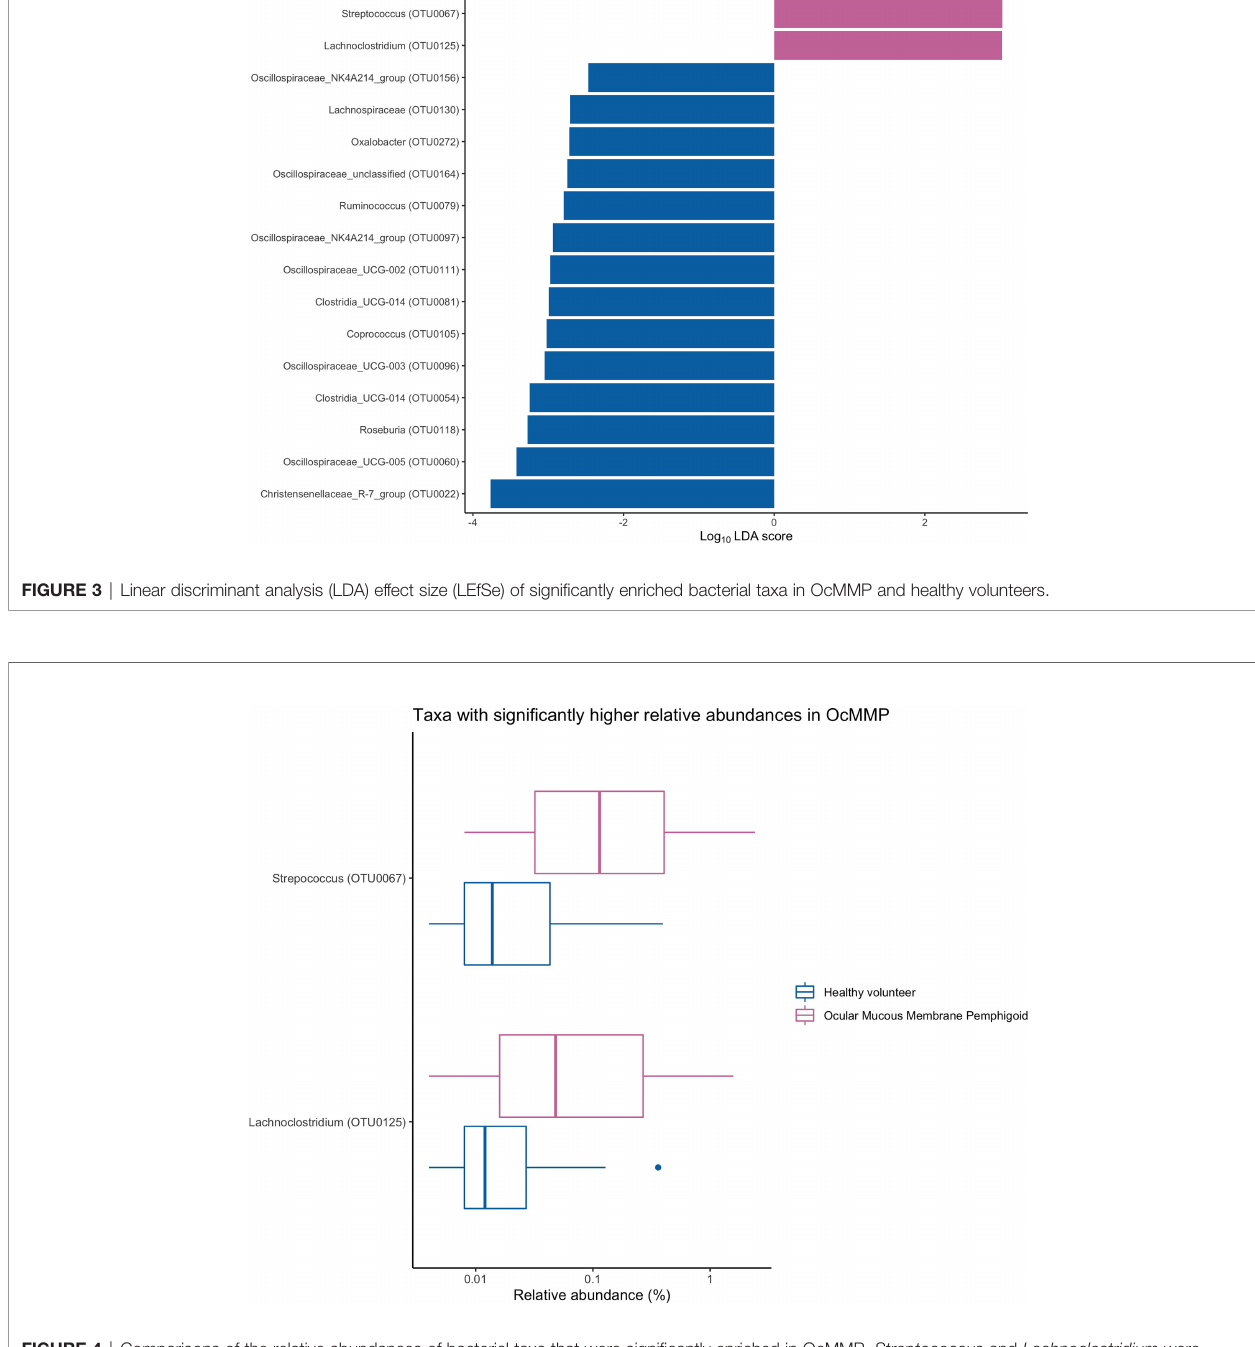
FIGURE 4 | Comparisons of the relative abundances of bacterial taxa that were signi fi cantly enriched in OcMMP. Streptococcus and Lachnoclostridium were signi fi cantly enriched in OcMMP